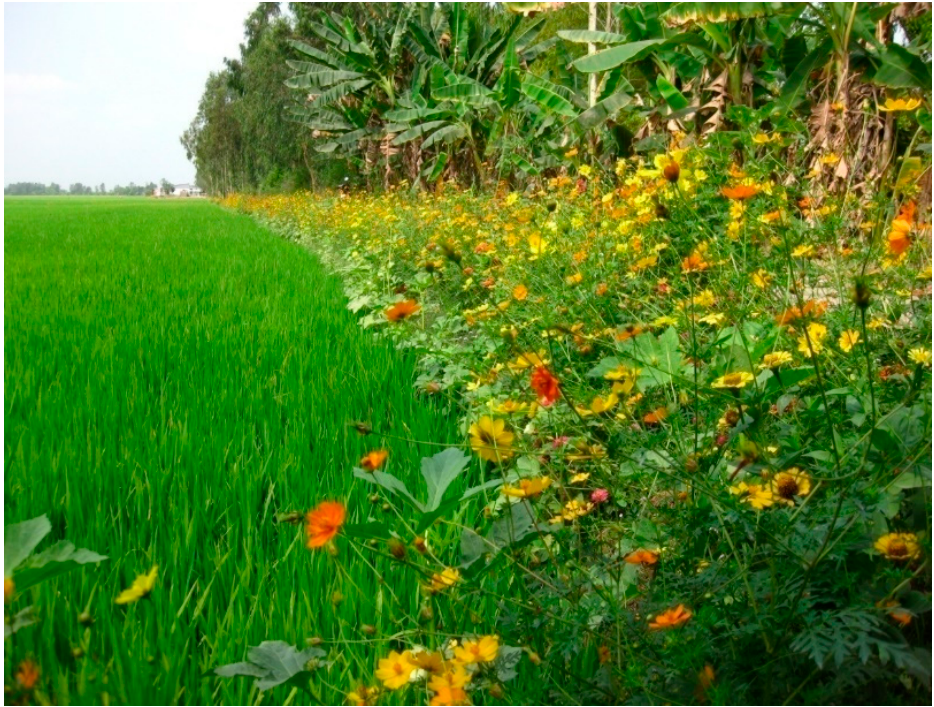
Figure 2. Vegetation diversification to provide resources to natural enemies in Vietnam. Photo taken in 2010 by HVC.